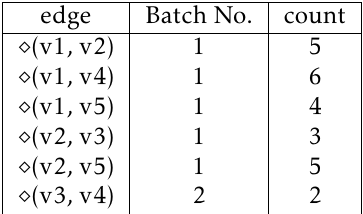
Table 8. Frequent Edges with count for Batch 1 and Batch 2 edge Batch